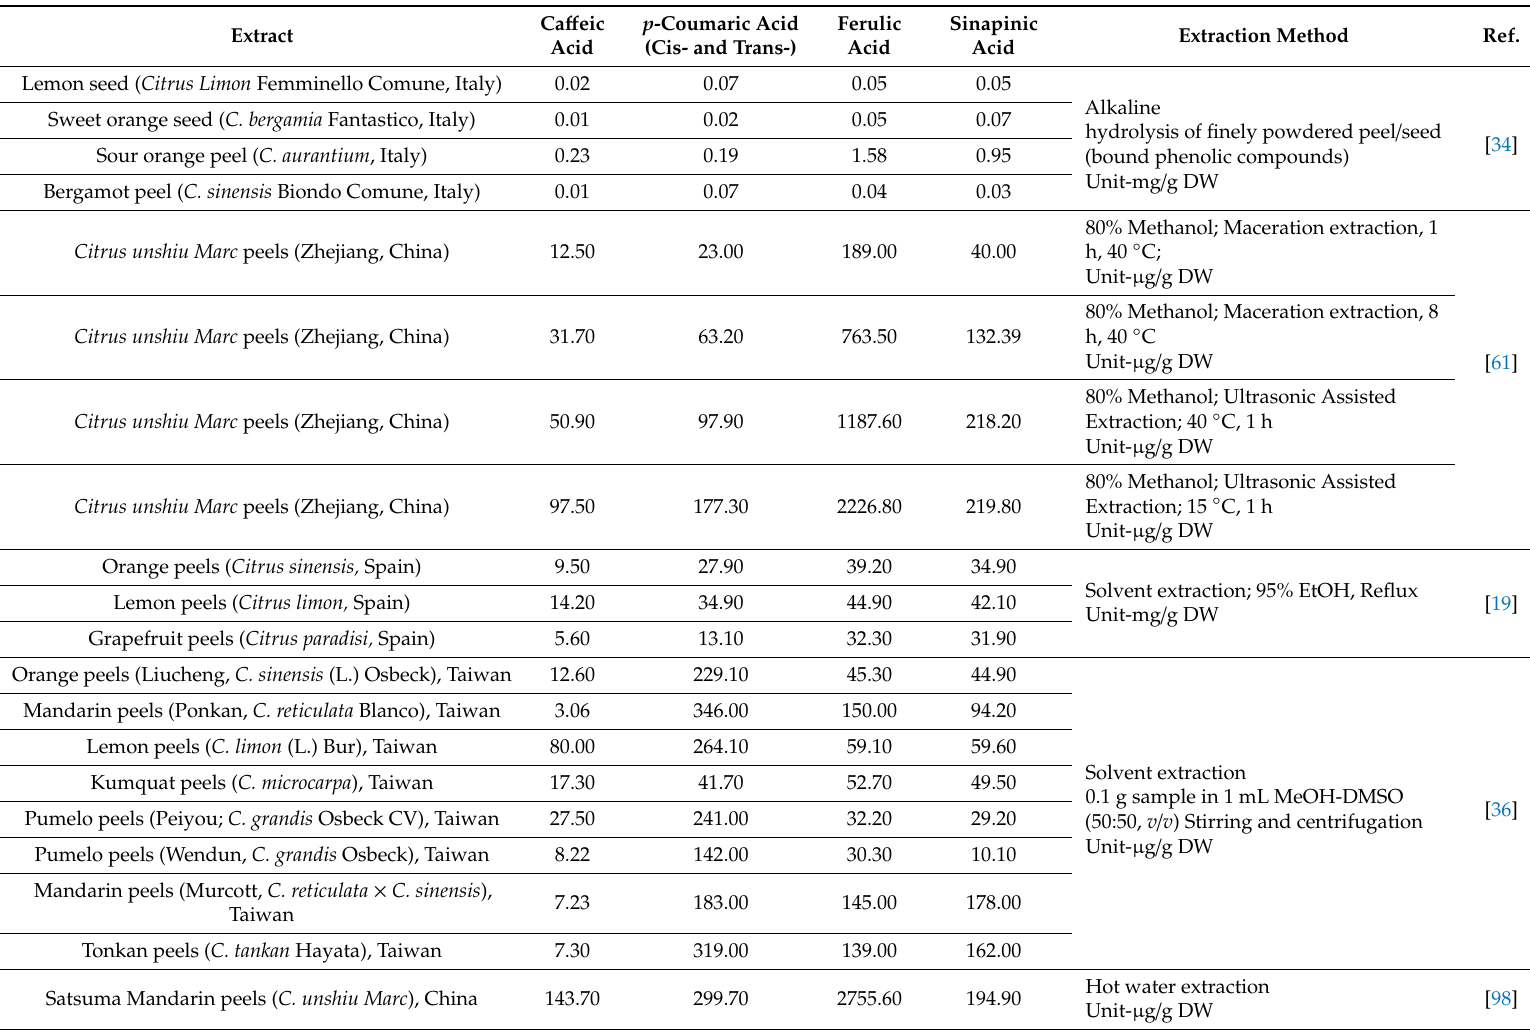
Table 5. Phenolic acid composition of peels and seeds in di ff erent varieties of citrus. Ca ff eic Extract Acid